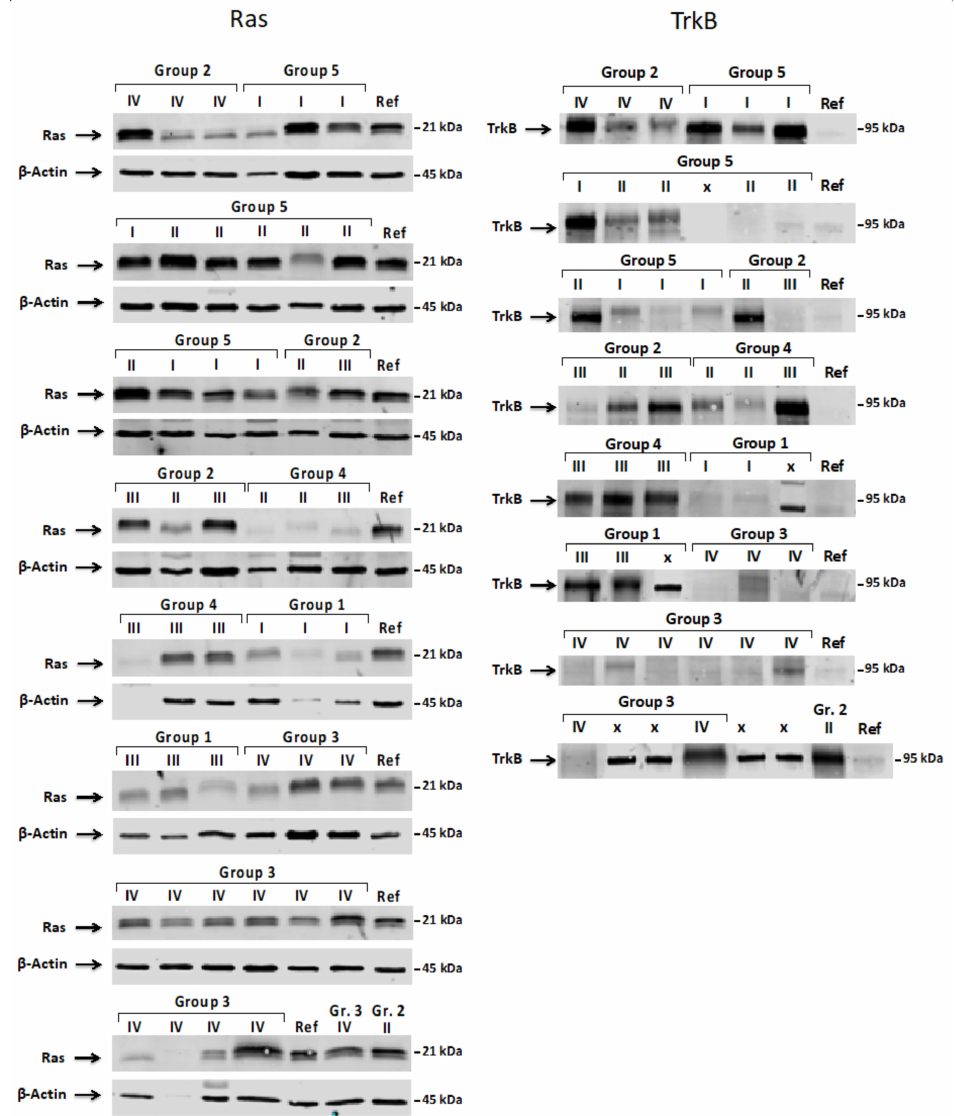
Figure 7. Western blot analysis of Ras and TrkB proteins levels in investigated pediatric brain tumors. The figure shows a representative image of the Ras and TrkB levels. The assignment to the tumor type and tumor grade is shown above the individual samples. Group 1—choroid plexus tumors; Group 2—diffuse astrocytic and oligodendroglial tumors; Group 3—embryonal tumors; Group 4— ependymal tumors; Group 5—other astrocytic tumors. Roman numerals (I, II, III, and IV) represent the grade of malignancy based on the WHO grade, representing the severity and prognosis of the condition. Reference sample (Ref). The level of Ras and TrkB was assessed immunochemically with the use of specific antibodies and subjected to the statistical analysis described in the Materials and Methods